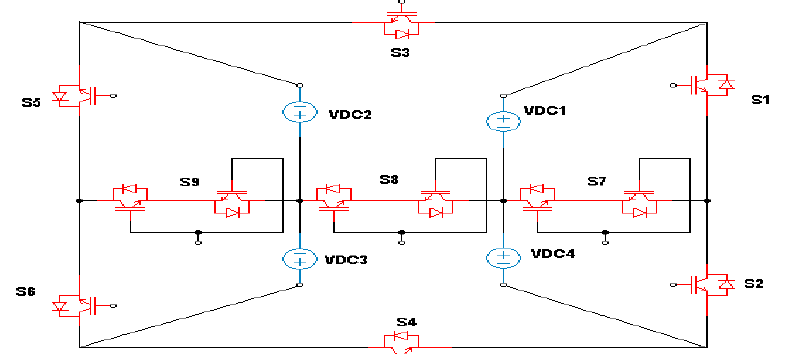
Figure 13. ST-Type module of multilevel inverter. Table 2 represents a comparison among the different T-Type MLIs that are discussed.